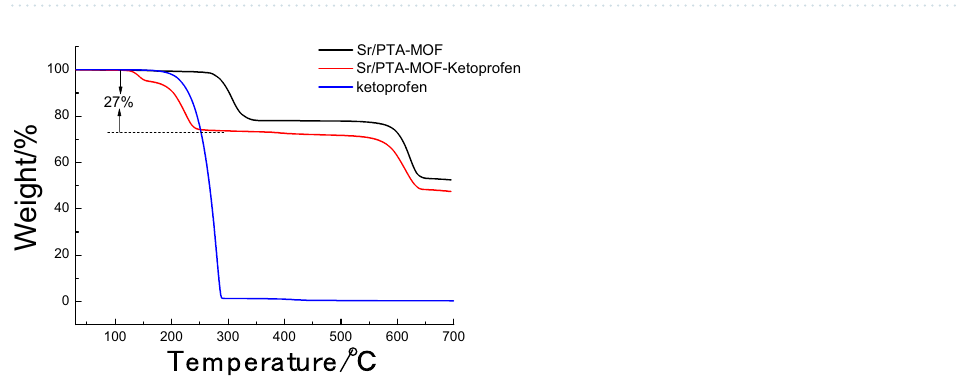
Figure 3. The FTIR analysis of Sr/PTA-MOF before and after loading ketoprofen.